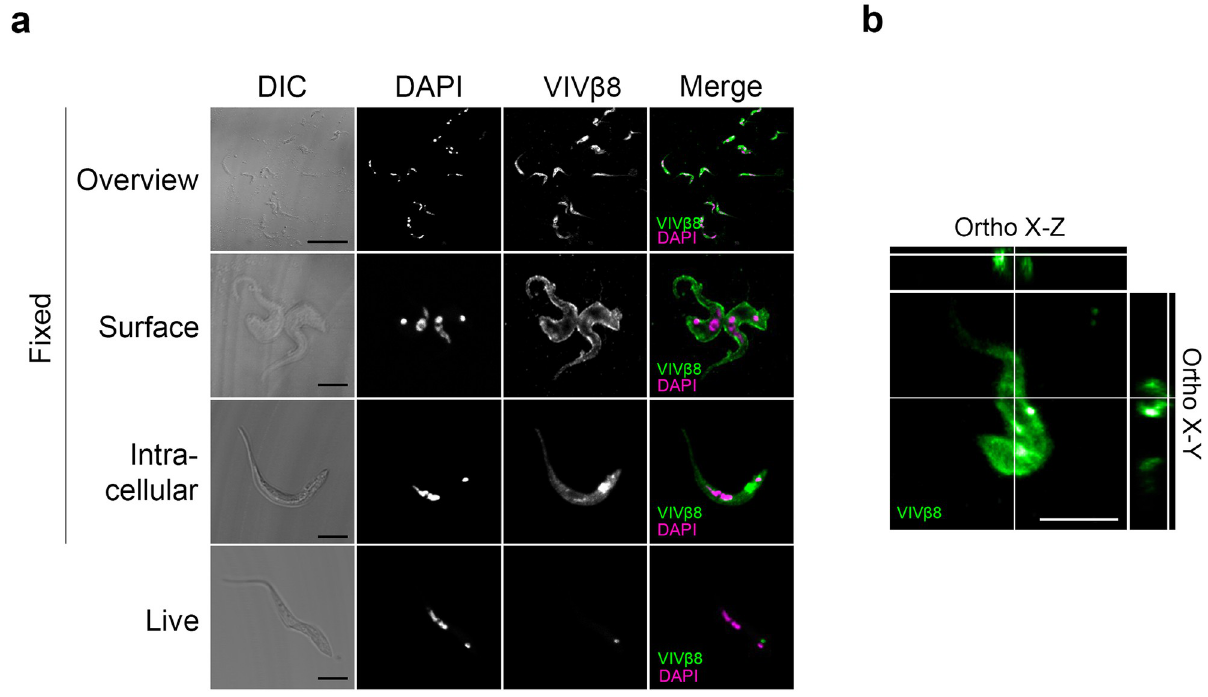
Fig 4. Cellular localization of VIV β 8 protein. (A) Representative images of immunofluorescence assays on T . vivax bloodstream forms fixed in 4% formaldehyde or on live cells. Differential increased contrast (DIC); DAPI DNA counterstain; VIV β 8 (secondary antibody AF555-conjugated) and merged channels. Formaldehyde-fixed cells exhibit three main staining patterns; cell surface (Surface), increasing gradient from anterior to posterior end (Gradient), and intracellular mainly (Intracellular). Scale bars; 5 μ m. (B) 3D z-stack reconstructions of T . vivax cells and corresponding orthogonal (X-Z and X-Y) views from the stacks. Orthogonal views note surface localization (circular edges) of VIV β 8 in T . vivax .